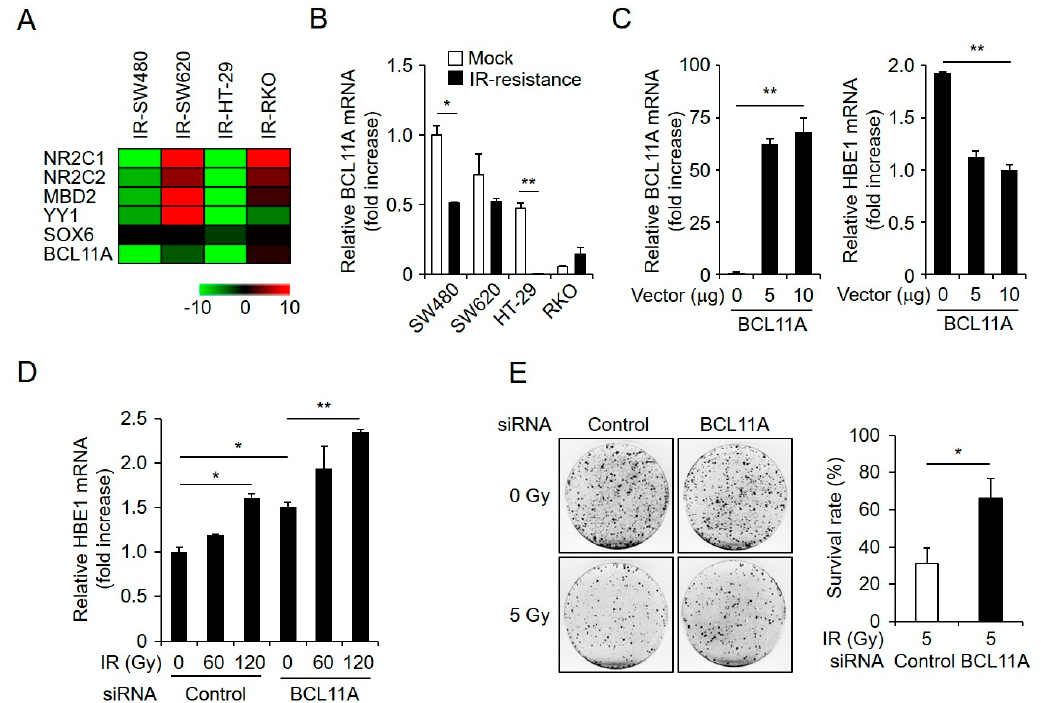
Figure 5. HBE1 expression is negatively regulated by the depletion of BCL11A expression. ( A ) Heatmap of differentially expressed HBE1 suppressor candidate genes ( B ) qRT-PCR confirmation of a candidate HBE1 suppressor gene selected based on RNA-seq analysis. * p < 0.05, ** p < 0.01. ( C ) Cells were transfected with a pCMV6-BCL11A-overexpression vector in a vector DNA concentration-dependent manner and changes in the mRNA expression level of BCL11A (left) and HBE1 (right) were analyzed by qRT-PCR. ** p < 0.01 compared to control cells. ( D ) Cells were transfected with control or BCL11A siRNA and exposed to gamma-irradiation (60 and 120 Gy). HBE1 mRNA levels were assessed by qRT-PCR. * p < 0.05, ** p < 0.01 compared to non-irradiated cells. ( E ) Representative image of clonogenic assay cells stained with crystal violet (left panel) and a graph showing mean survival rate as a function of radiation for negative control- or siBCL11A-treated cells. * p < 0.05 compared to control